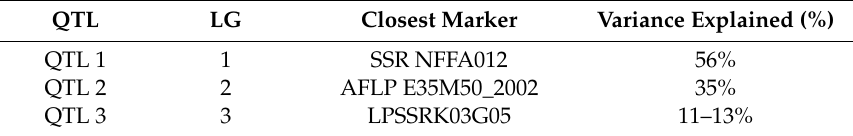
Table 3. QTLs (Quantitative Traits Locus) detected by Studer et al. [126] for ryegrass crown rust in L. multiflorum